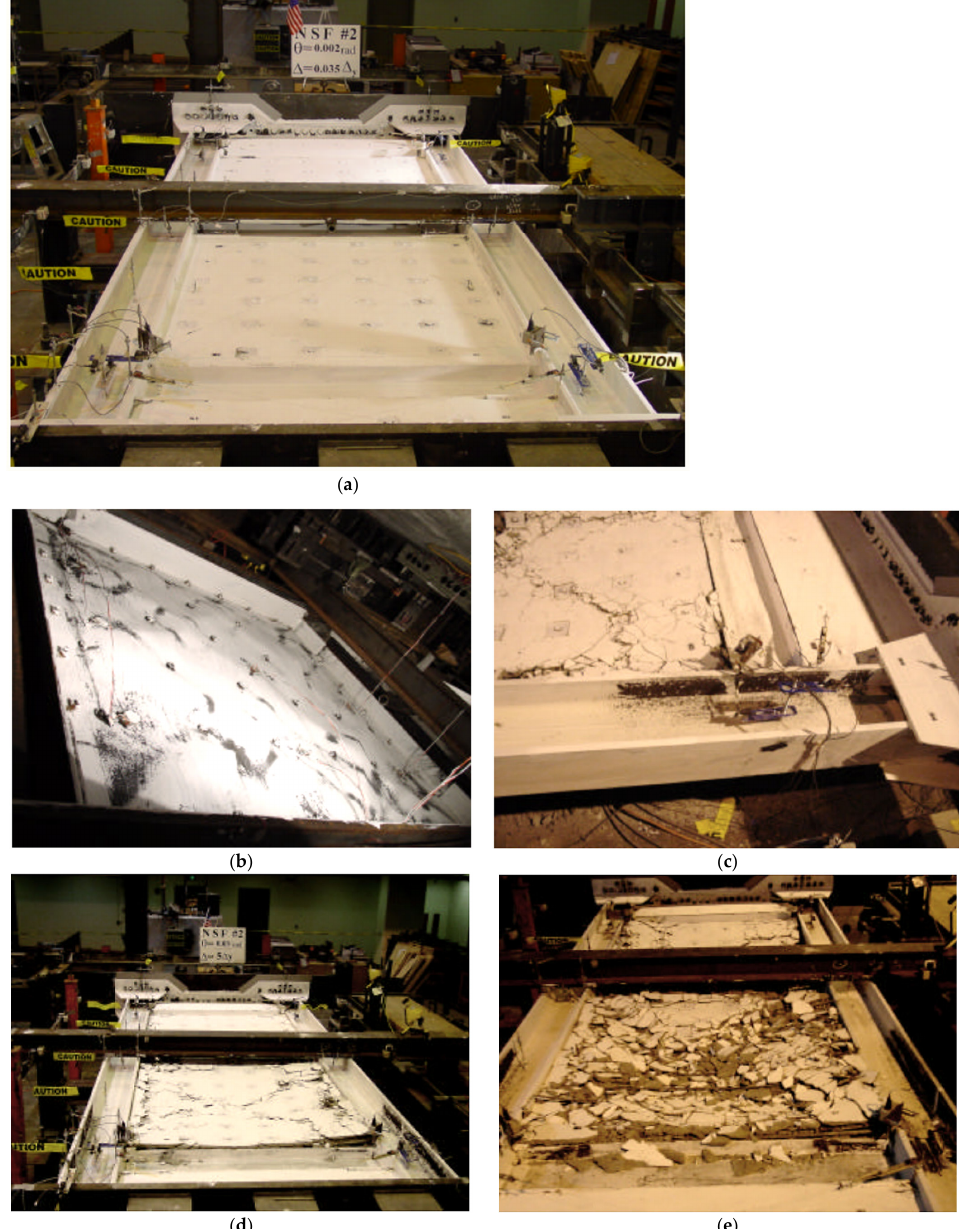
Figure 5. Local buckling, out ‐ of ‐ plane and crack formation for experimental specimen. ( a ) A View of Test Specimen ( b ) steel plate buckling; ( c ) plastic hinge at the base of column; ( d ) concrete crack at mid of the test; ( e ) concrete crack at end of the test.